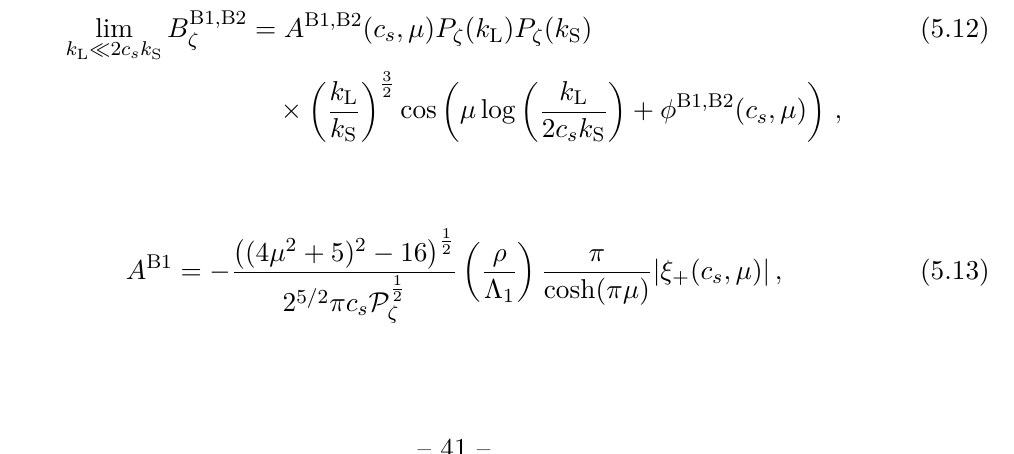
Figure 10 . The shapes of the bispectra S ( k 1 /k 3 , k 2 /k 3 ) , normalized to unity in the equilateral limit ( k = k = k ), for Diagram B1 ( left ) and Diagram B2 ( right ). Here we have set c 1 2 3 and µ = 2 . Both the approximate local-shape behaviour eqs. (5.9)–(5.10), and the resonances near squeezed configurations typical of the low speed collider are well